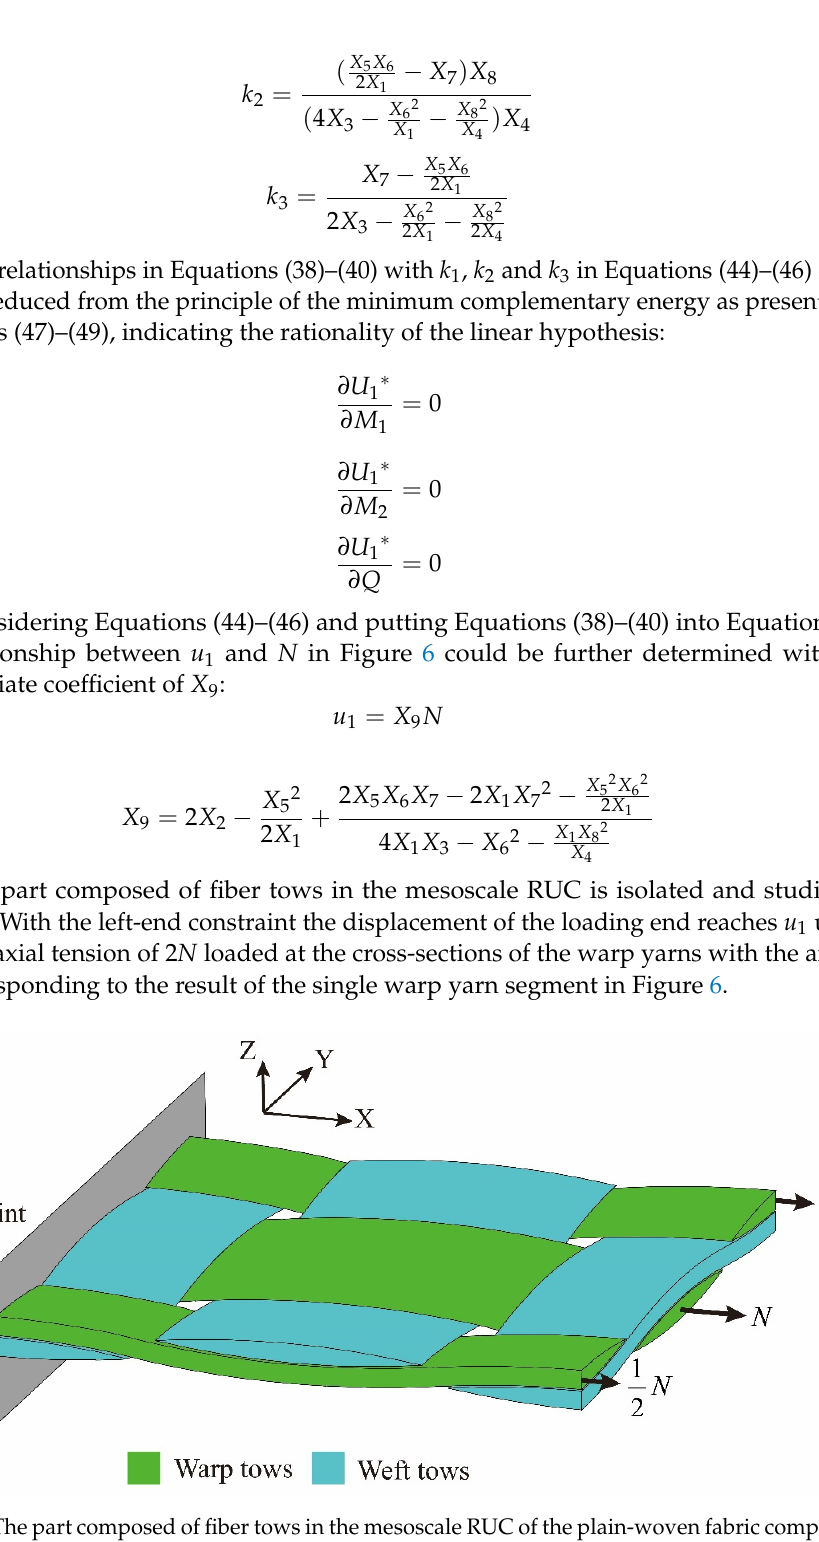
RUC, including a , b , r U and L RUC , are first obtained as inputs. The corresponding cross-